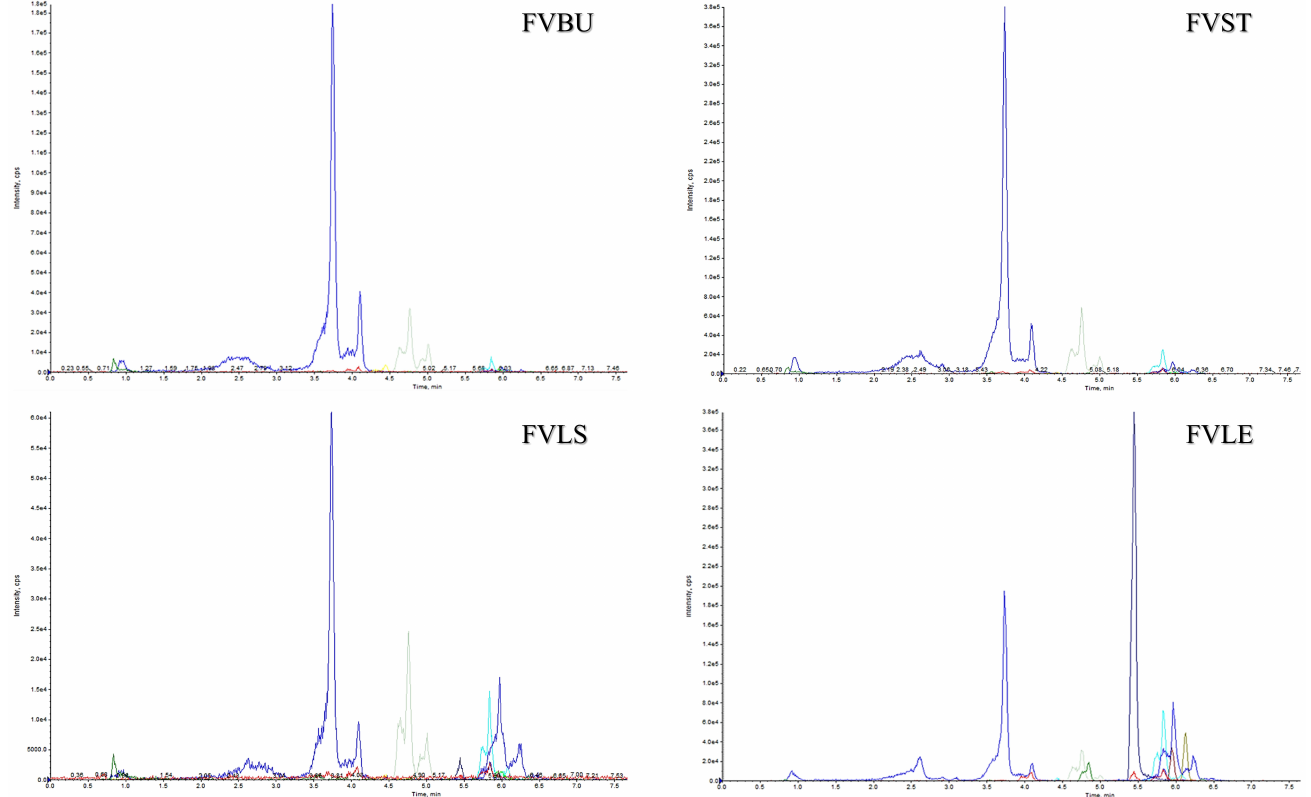
Figure 2. UHPLC-ESI-QTRAP-MS/MS profiles of bulb (FVBU), stem (FVST), little stem (FVLS), and leaf (FVLE) extracts of F. vulgare through analysis in MRM